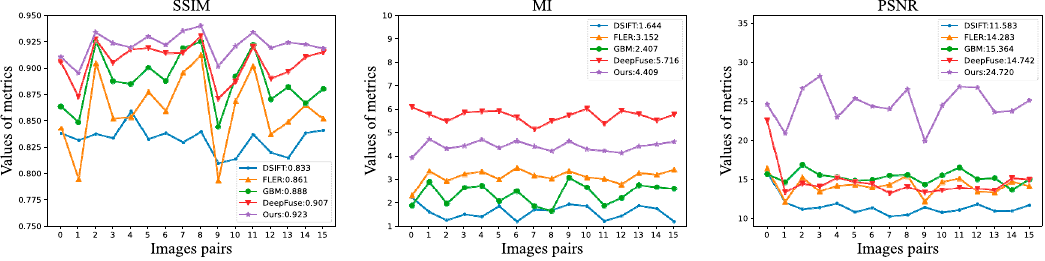
Figure 7. Quantitative comparisons of the SSIM, MI, and PSNR on 16 image pairs from our dataset. Table 1. Quantitative comparisons of the six